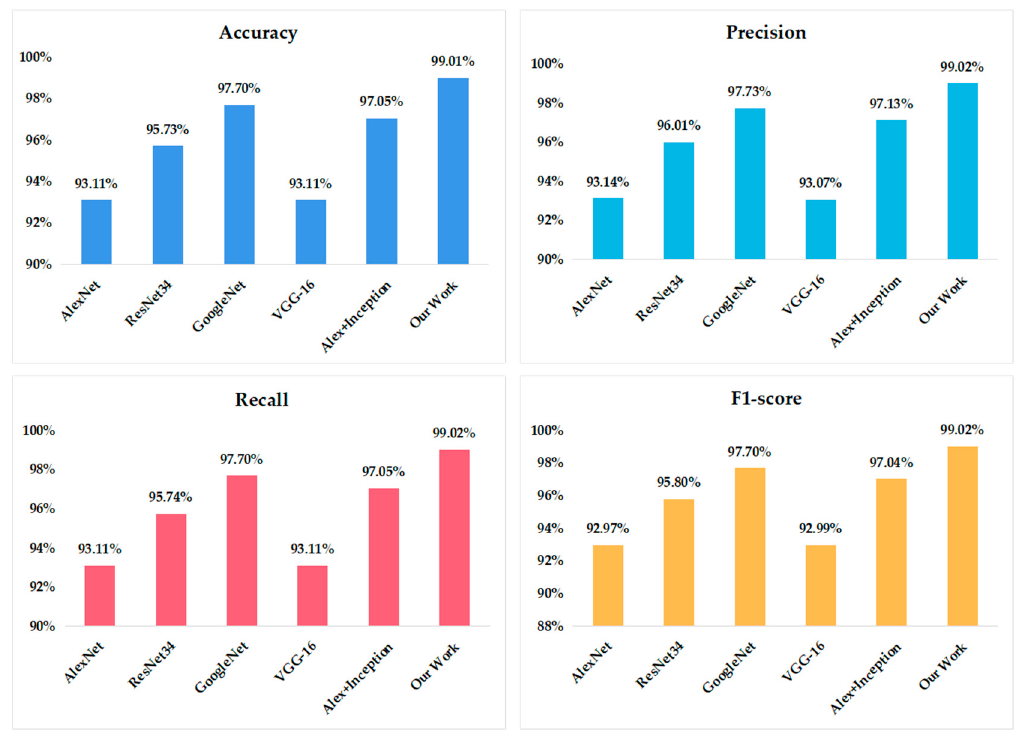
Figure 6. Recognition accuracy of different models.